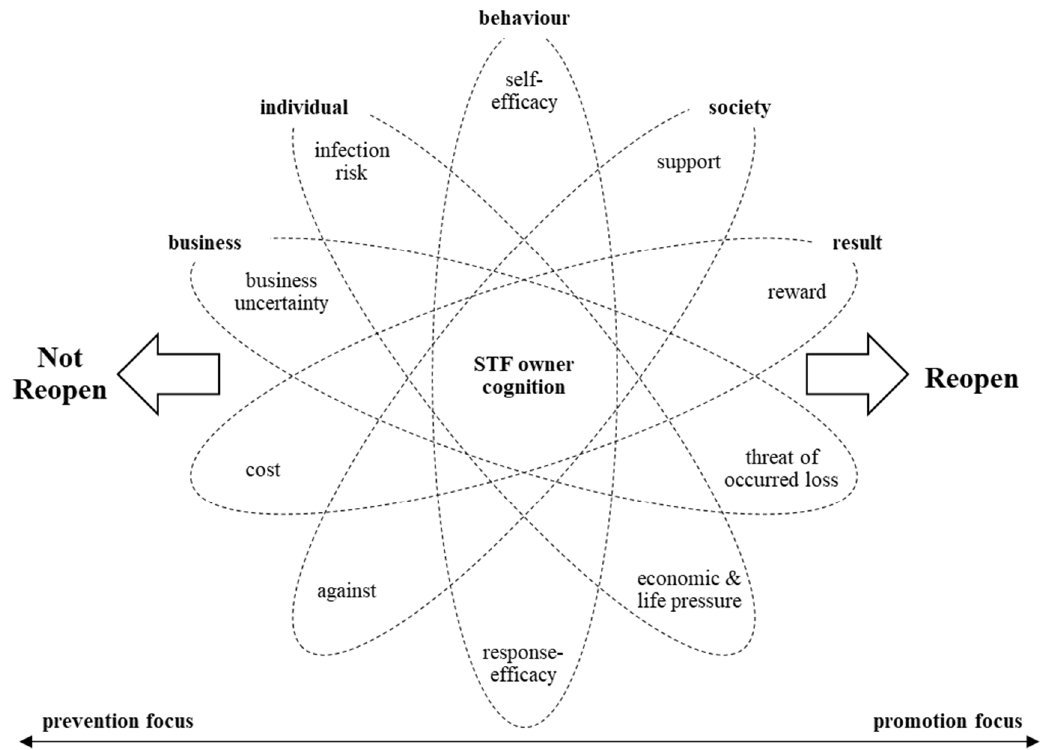
Figure 1. Schematic representation of STF owners’ business decision to reopen. Source: Adapted from [31,32].